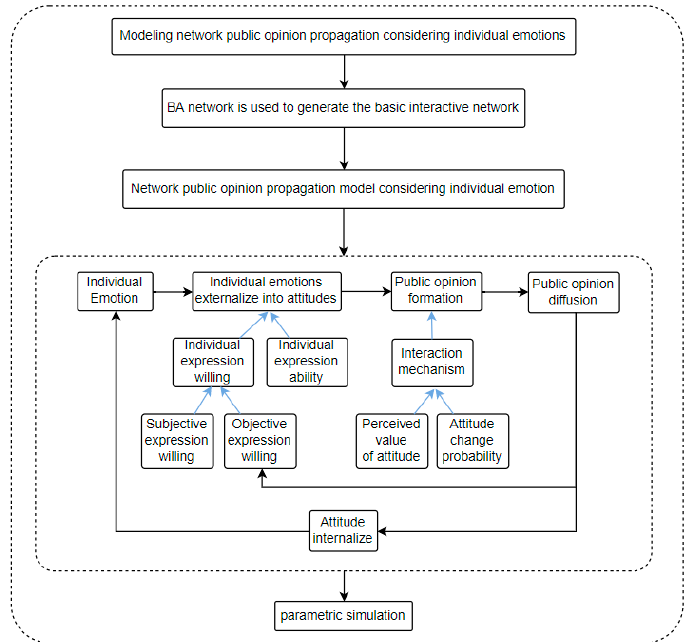
Figure 1. Research structure.